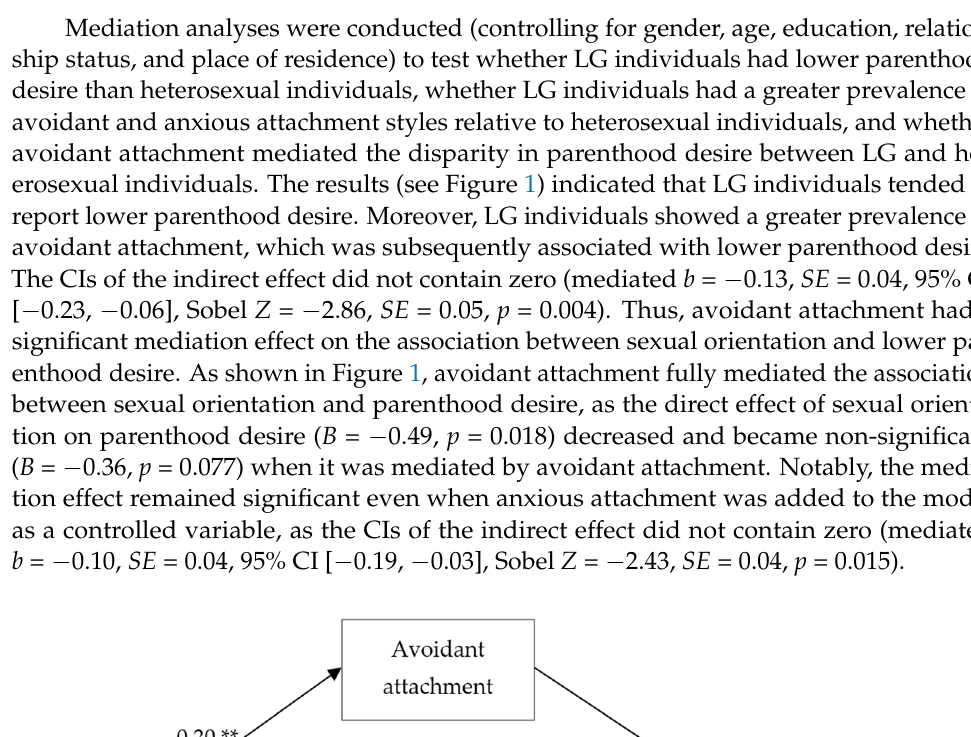
Figure 2. The mediation effect of anxious attachment on the association between sexual orientation and parenthood desire. Note. N = 789. The reported values are unstandardized regression coeffi- cients ( B s) for the pathways between sexual orientation (0 = heterosexual, 1 = sexual minority), avoidant attachment, and parenthood desire. Gender, age, education, relationship status, and place of residence were used as covariates. The total effect of sexual orientation on parenthood desire is reported in parentheses. * p < 0.05. ** p < 0.01. To explore whether the significant mediation model of avoidant attachment in the association between sexual orientation and parenthood desire differed as a function of gender (i.e., men vs. women), conditional process analysis was applied, focused on the possible moderating effect of gender in the association between sexual orientation and avoidant attachment. The Cis of the moderated mediation indices [58] did not contain zero (index = −0.13, SE = 0.07, 95% CI [−0.29, −0.07]) when predicting parenthood desire using avoidant attachment as a mediator, and the conditional indirect effect of the mediation